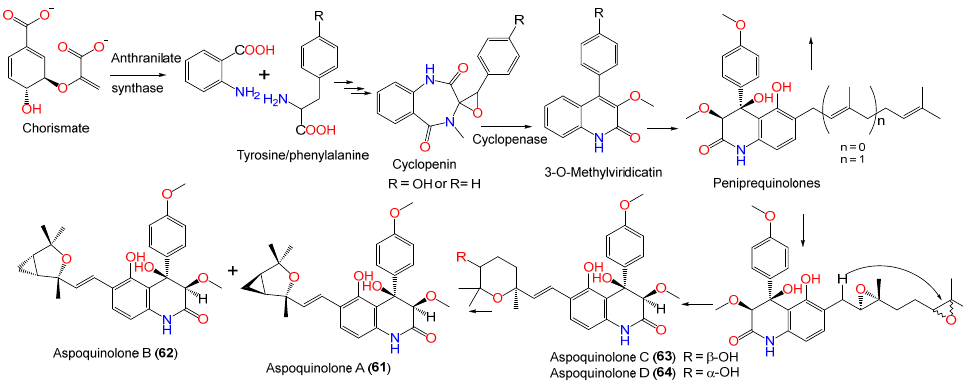
*Mol. Wt.: Molecular weight; Mol. Formula: Molecular